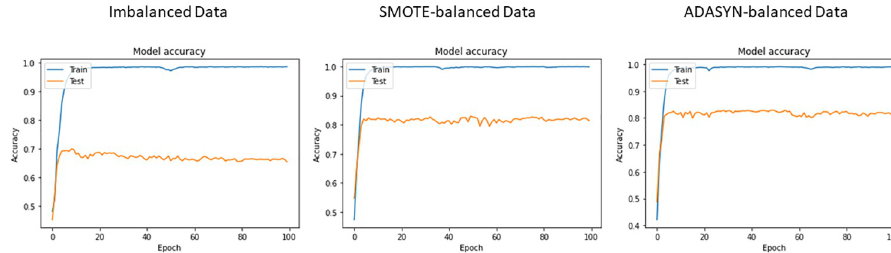
Fig 8. Accuracy measure of CNN with respect to each